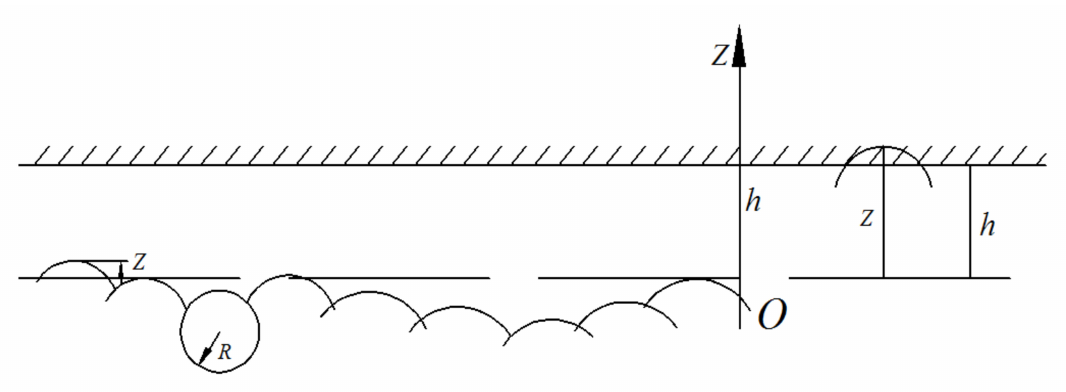
Figure 3. Greenwood and Williamson random surface